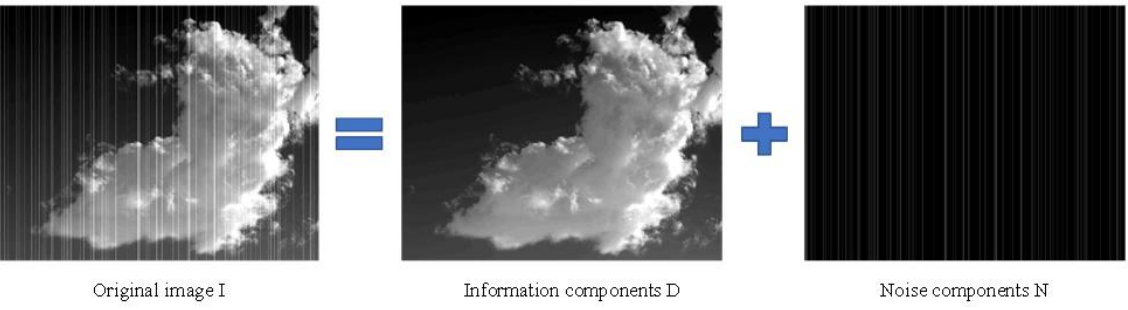
Figure 1. Block diagram of the proposed